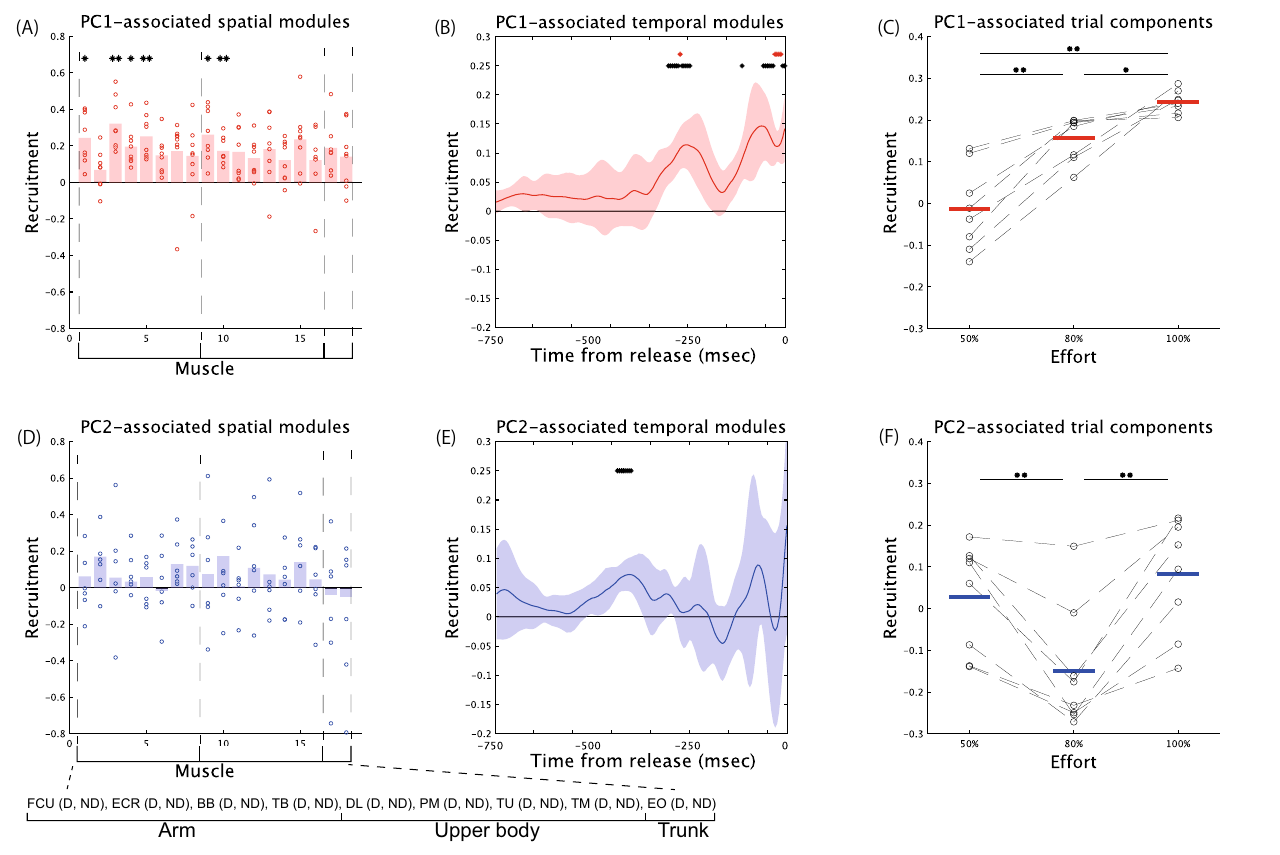
Figure 5. The spatiotemporal modules associated with PC1 and PC2 of the trial components. ( A – C ): PC1- associated spatial module, temporal module, and trial component. Double asterisks and single asterisks in panel ( A ) indicate significant differences from 0 with p < 0.01 and p < 0.05 through a t -test with Bonferroni’s correction. Red and black asterisks in panel ( B ) demonstrate significant differences from 0 with p < 0.01 and p < 0.05 via a t -test with Bonferroni’s correction. The muscle type associated with the muscle number in panel ( A ) is listed at the bottom part of this figure. The dotted lines in panel ( C ) indicate the effort-dependent effects on trial components in each subject. Double asterisks above the horizontal solid black line demonstrate a significant difference with p < 0.01 (Tukey’s comparison test). A single asterisk indicates a significant difference with p < 0.05. ( D – F ): PC2-associated spatial module, temporal module, and trial